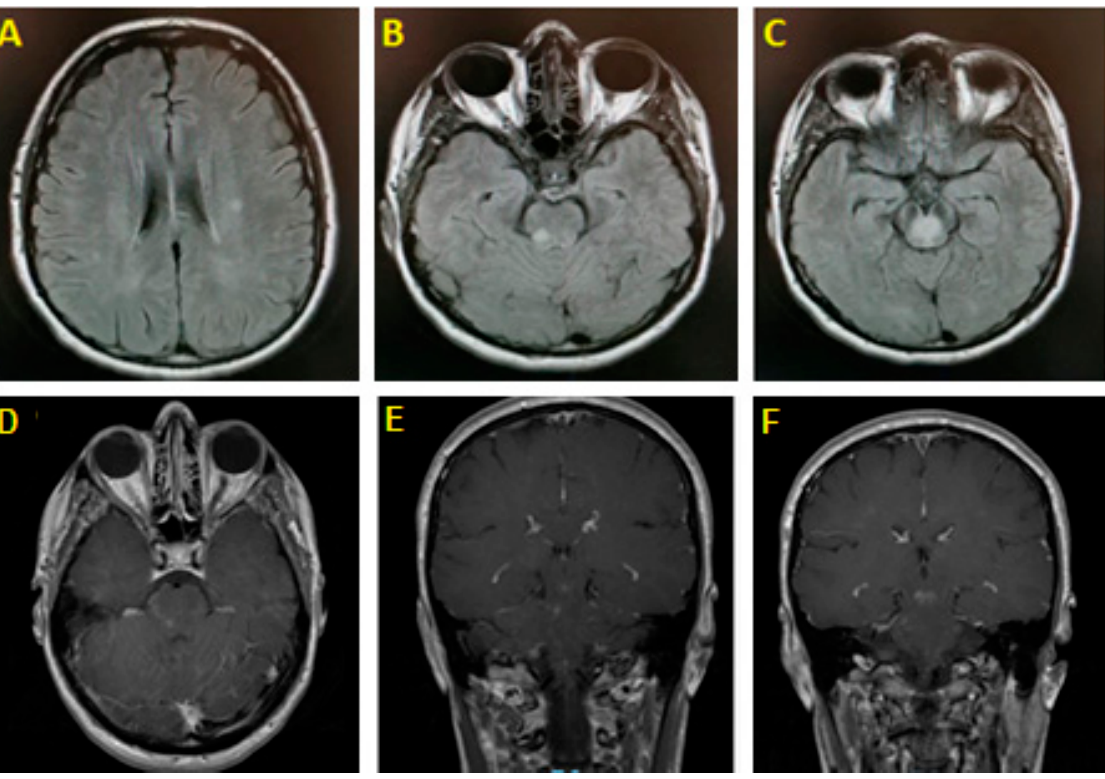
Figure 1. ( A ): Axial T2/FLAIR shows bilateral foci signal hyperintensities in the subcortical white matter. ( B ): Right pontine T2/FLAIR hyperintensity. ( C ): Midbrain hyperintense signal. ( D–F ): Subcortical lesions showing postcontrast enhancement.